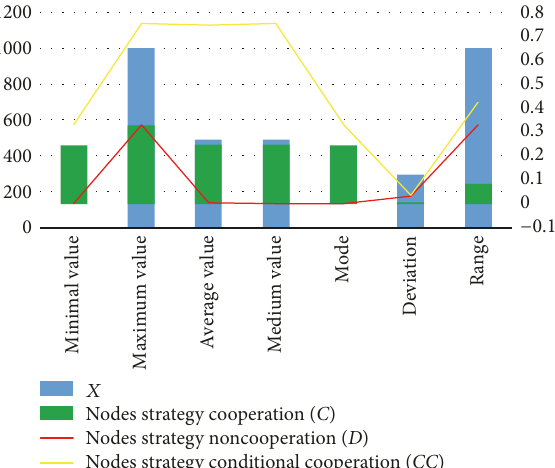
Figure 24: The state of population when 𝑋 = (0, 1000, 487.3, 457.2, 0, 288.7, 1000).